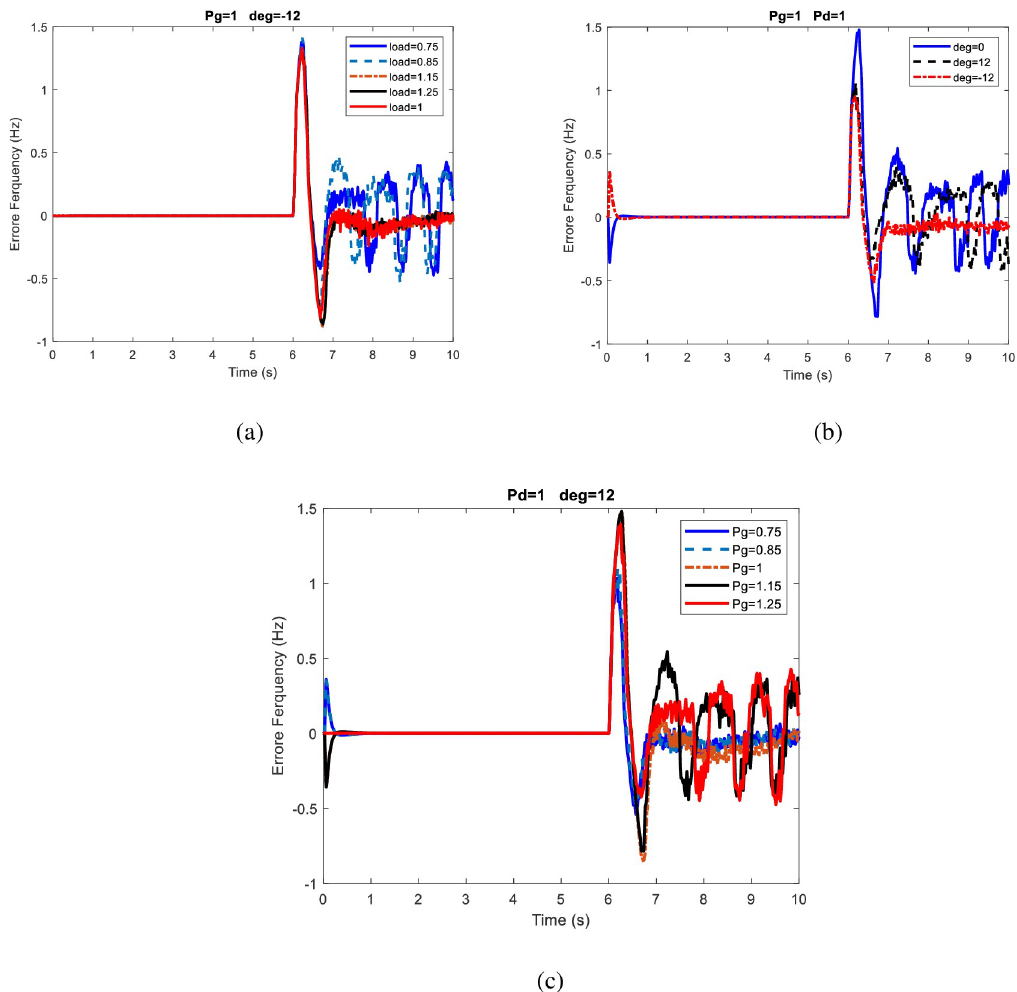
Fig 9. Comparison of frequency deviation in different cases for the fourth